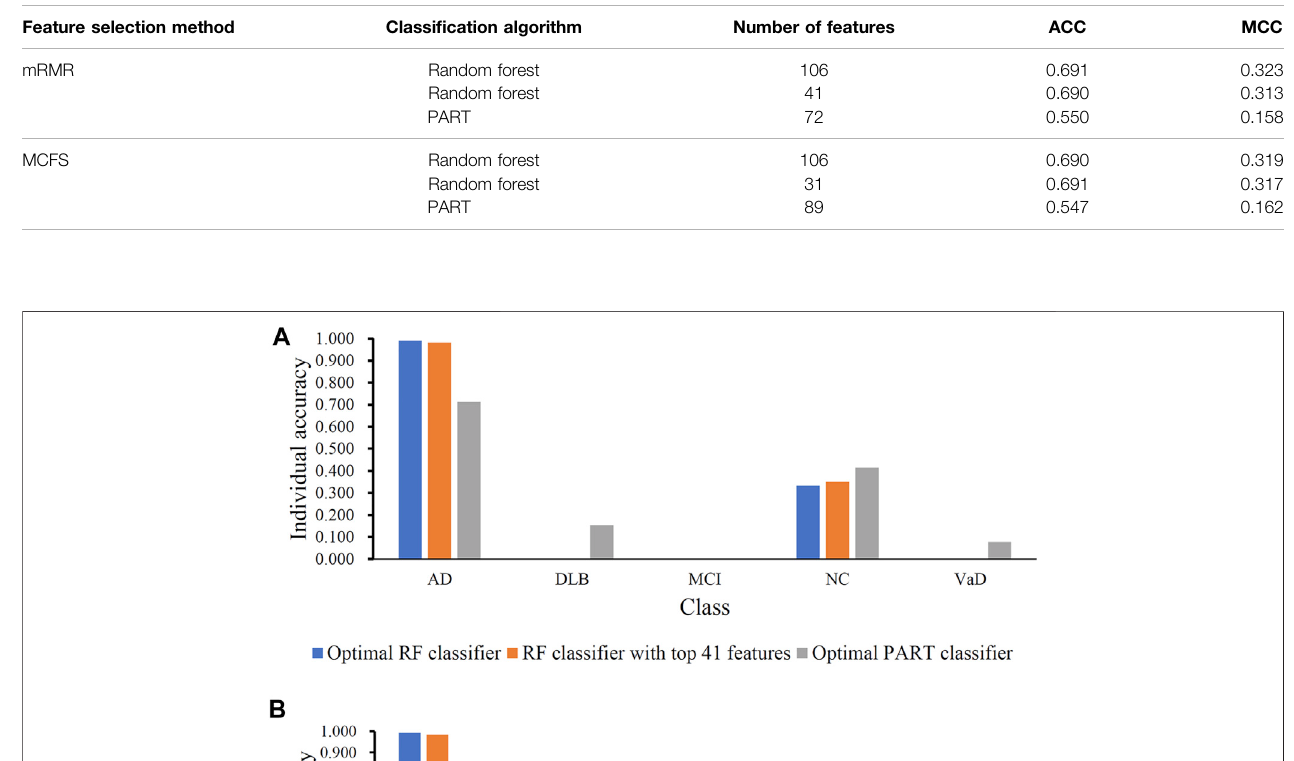
TABLE 6 | Performance of key classi fi ers without SMOTE.